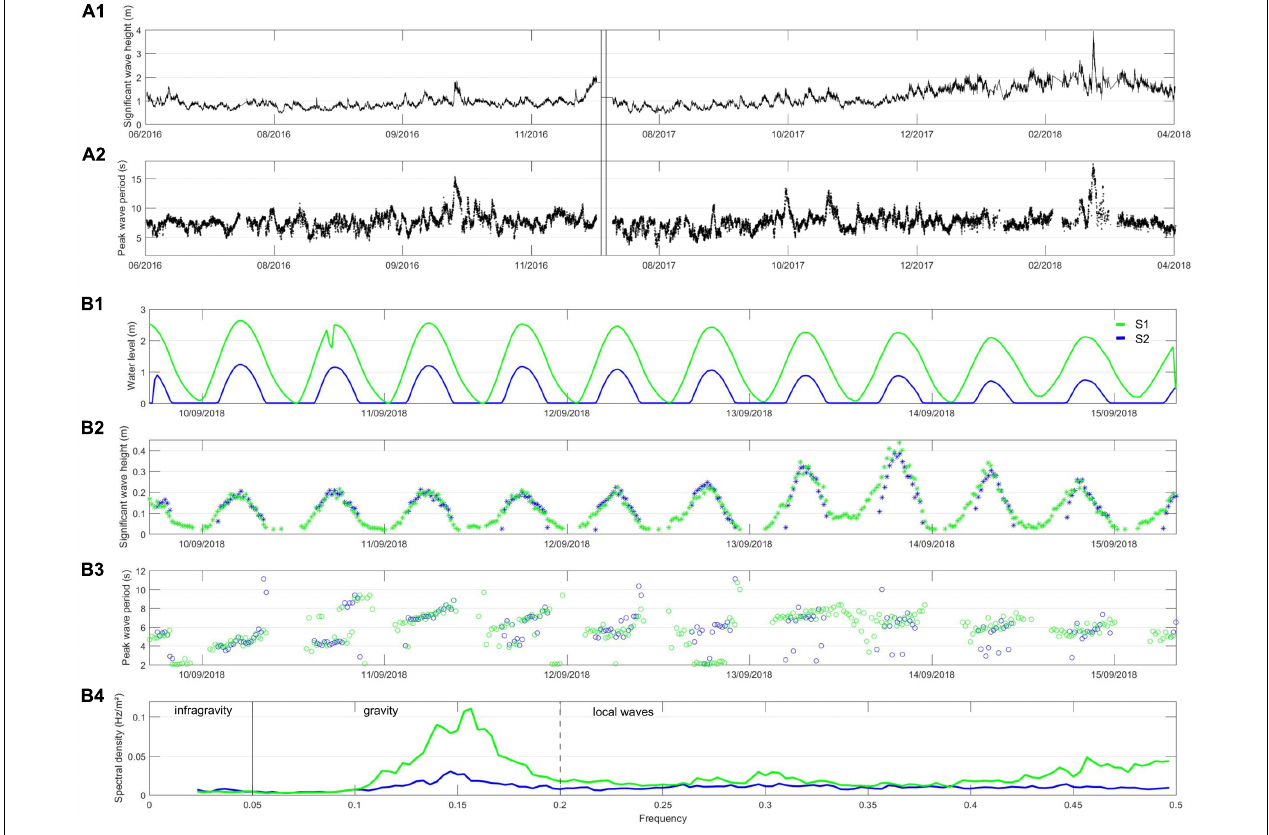
FIGURE 9 | Hydrodynamic conditions during the course of the field experiments. From top to bottom: offshore significant wave heights (A1) and periods (A2) measured by the CANDHIS buoy offshore of Cayenne (see Figure 1A ); water levels measured by the pressures sensors (B1) ; inshore wave heights (B2) and periods (B3) measured by the pressure sensors (see Figure 2 ); and examples of bursts of wave energy spectral density (B4) .